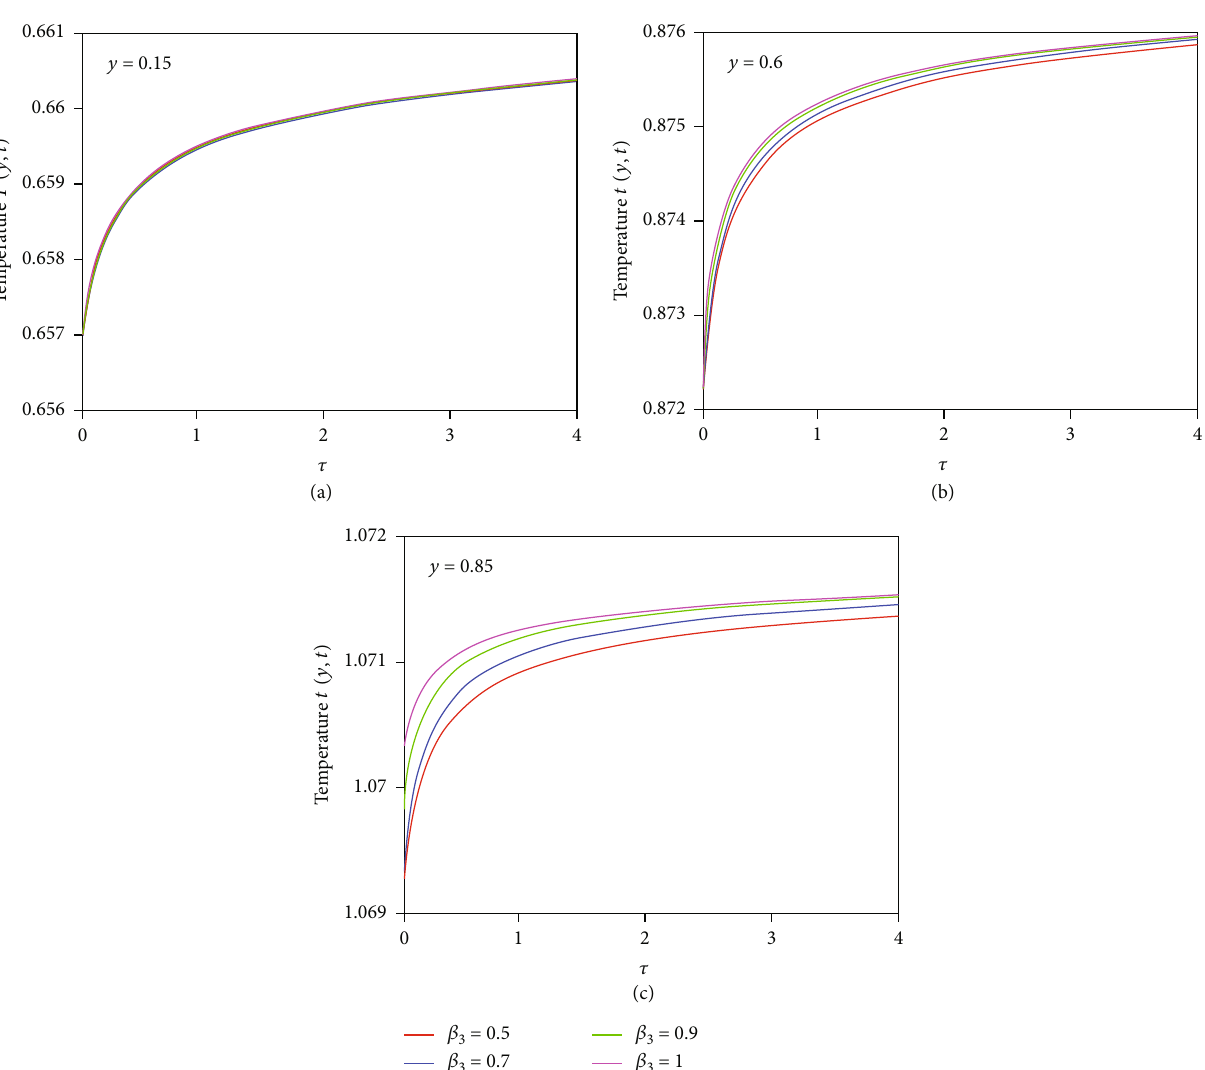
ð y , t Þ , i = 1, 2, 3 versus t for fractional multilayer Maxwell fl uid at β i